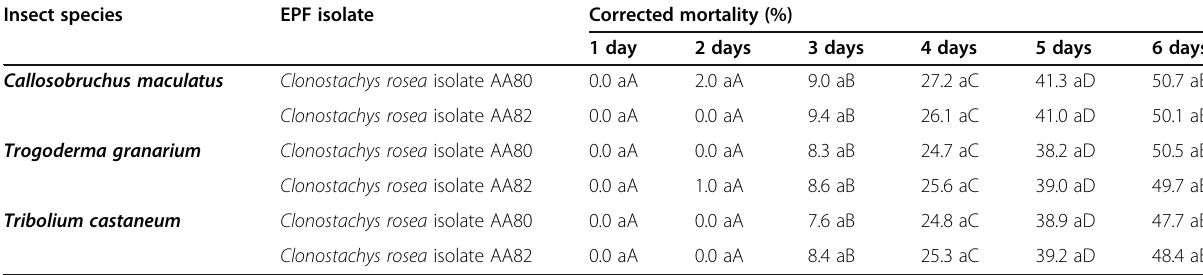
Table 3 The corrected mortalities of Callosobruchus maculatus , Trogoderma granarium and Tribolium castaneum adults treated with conidia of two Clonostachys rosea isolates. The conidial concentration of each entomopathogenic fungal isolate used for treatment